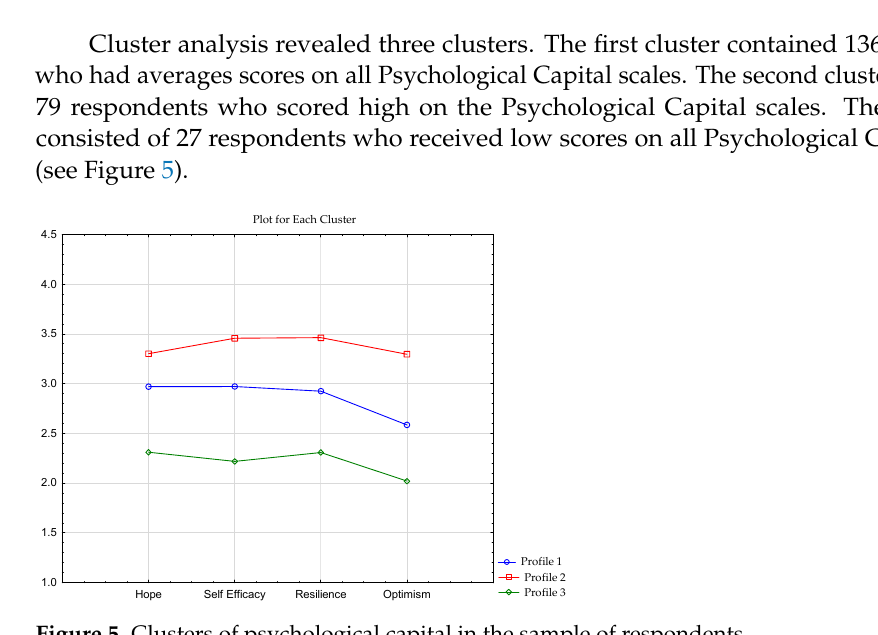
Figure 5. Clusters of psychological capital in the sample of respondents.